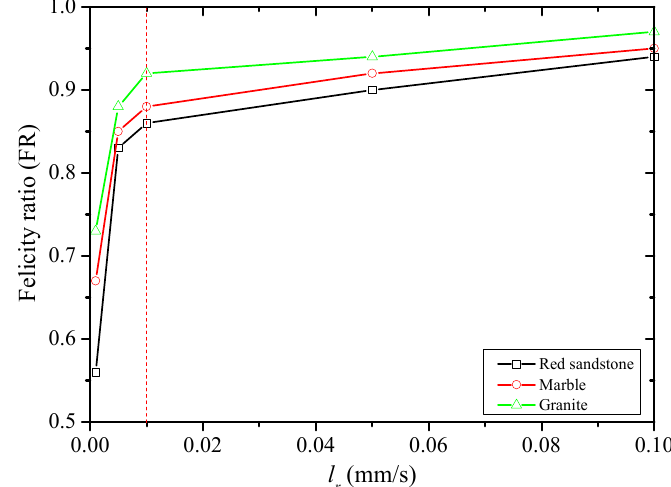
Figure 11. FR values of three types of rocks under different loading rate conditions.